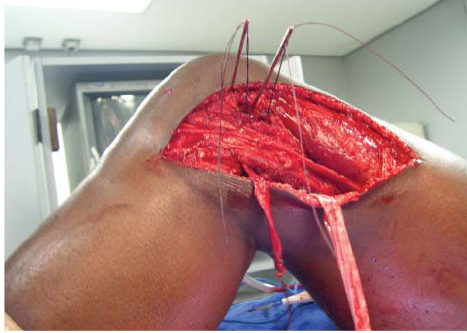
Figure 7 - Placement of guide-wires near the lateral femoral epicondyle, previous to tunnel confection.